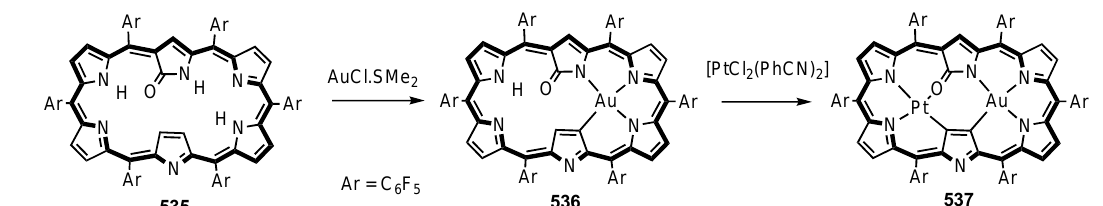
Scheme 80. Organometallic derivatives of hexaphyrins(1.1.1.1.1.1).